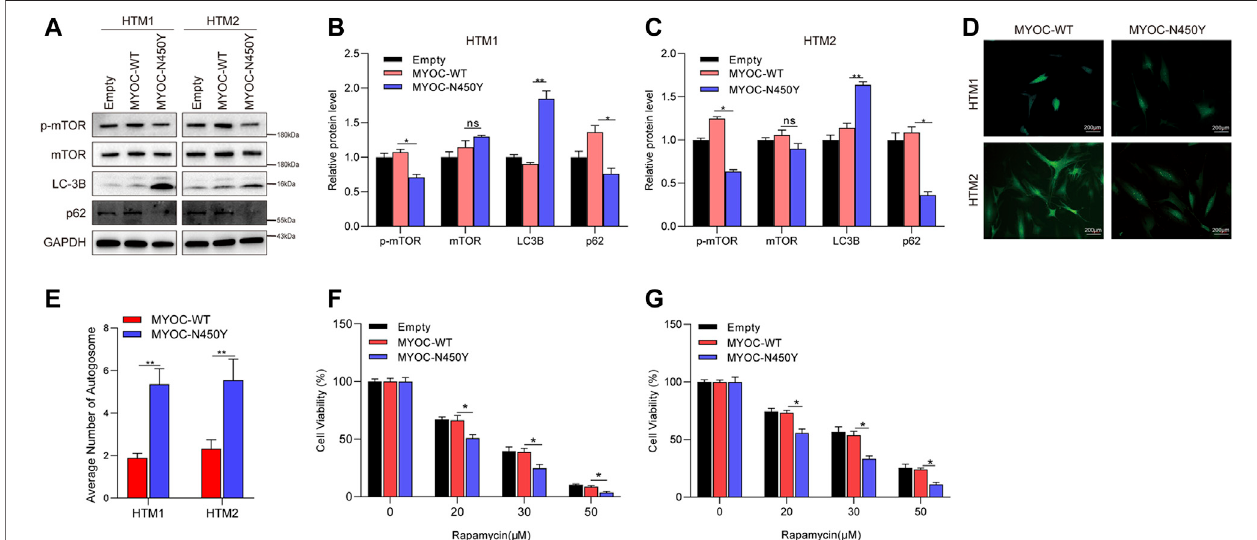
FIGURE 2 | N450Y mutant MYOC activates autophagy. (A) Western blot detection of mTOR, p-mTOR, LC3B, P62 and GAPDH (B,C) . Band intensity analysis in (A) usingImageJsoftware.*,p < 0.05;**,p < 0.01;ns,nosigni fi cance. (D) HTMcellswereinfectedwithlentivirusesexpressingMYOC-WTorMYOC-N450Yfor48 hand transduced with EGFP-LC3 for 24 h **, p < 0.01. (E) Number of autophagosomes in (D) . **, p < 0.01. (F,G) Cell viability was detected using CCK8 after rapamycin treatment. *, p < 0.05. Empty: empty vector lentiviruses; MYOC-WT: lentiviruses expressing wild type myocilin gene; MYOC-N450Y: Lentiviruses expressing N450Y mutant myocilin gene.